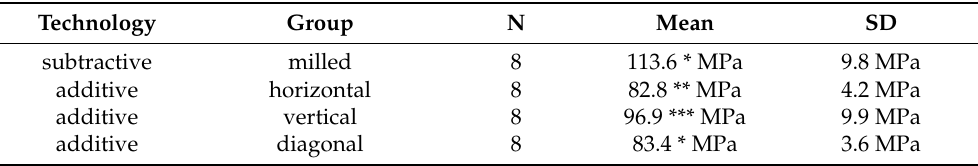
Table 1. Mean and standard deviation (SD) of the flexural strength of the subtractive and additive manufactured bars in megapascals (MPa).